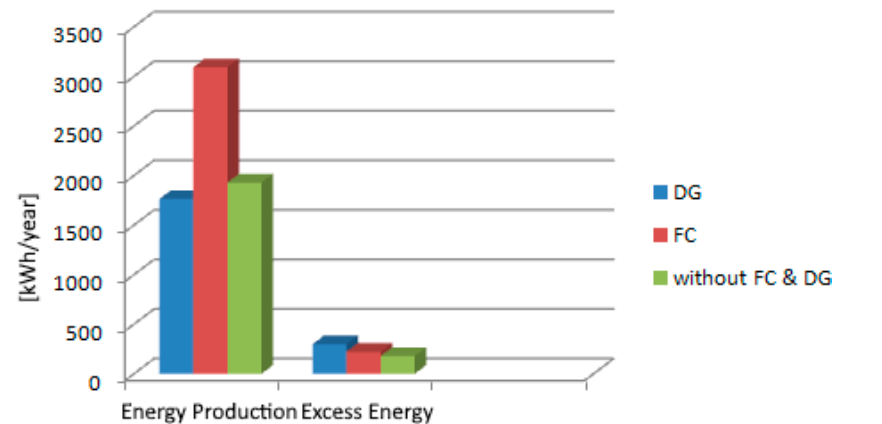
Figure 23. Electrical comparison of the three cases using iHOGA.